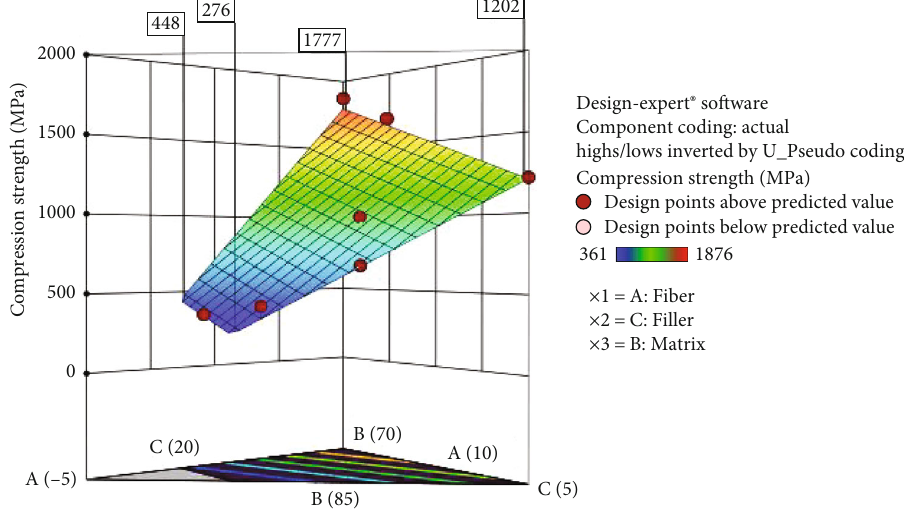
Figure 12: The e ff ect of fi ber, matrix, and fi ller weight % on compressive strength.